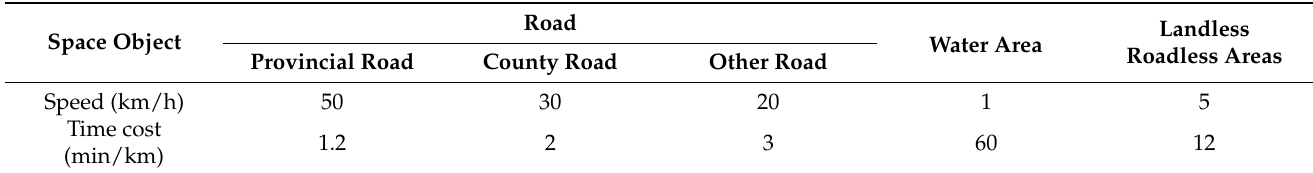
Table 2. Time cost values of different spatial objects.